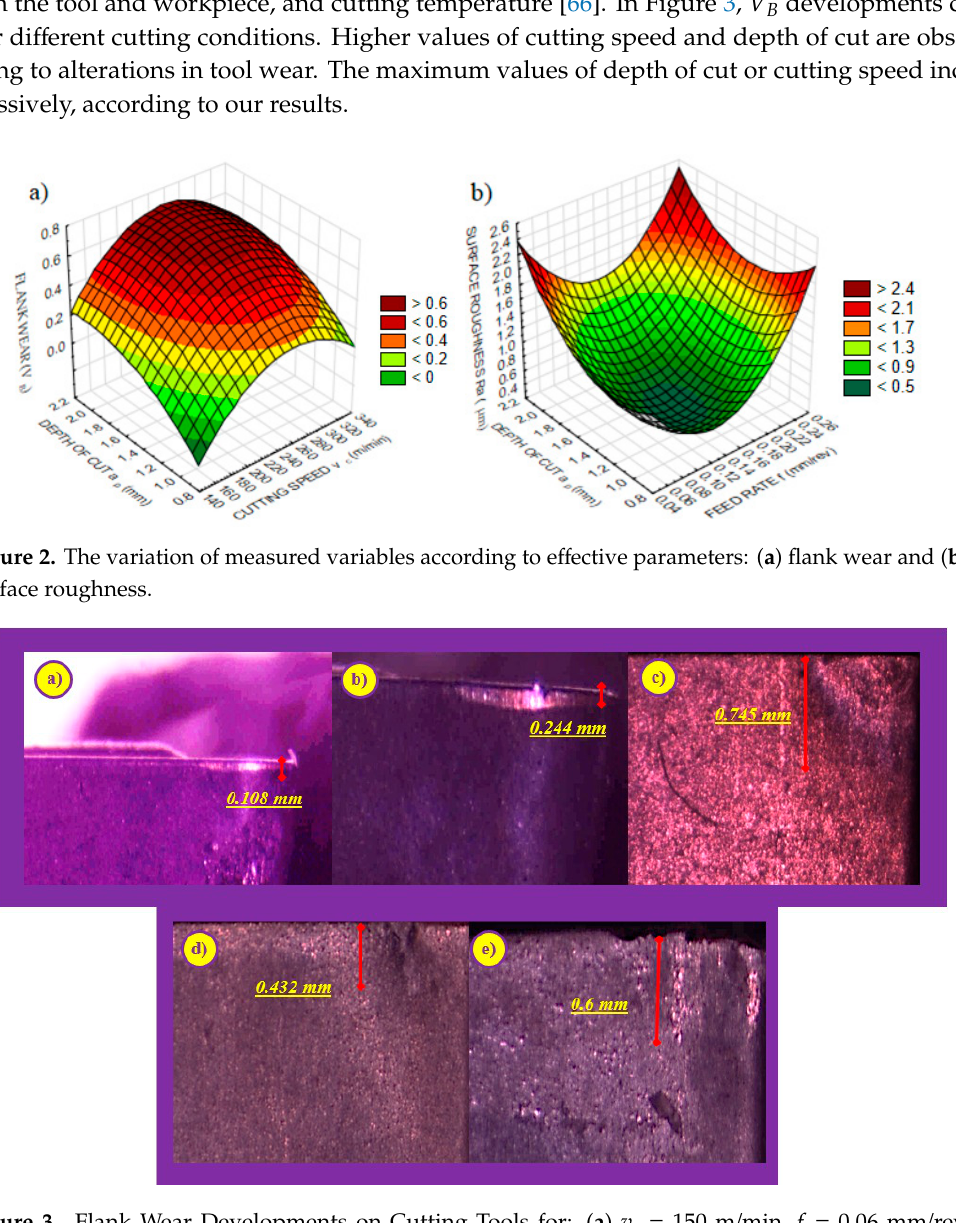
Figure 3. Flank Wear Developments on Cutting Tools for: ( a ) v c = 150 m/min, f = 0.06 mm/rev, a p = 1 mm; ( b ) v c = 150 m/min, f = 0.24 mm/rev, a p = 2 mm; ( c ) v c = 200 m/min, f = 0.12 mm/rev, a p = 2 mm; ( d ) v c = 330 m/min, f = 0.06 mm/rev; a p = 2 mm; ( e ) v c = 330 m/min, f = 0.24 mm/rev, a p = 1.5 mm.